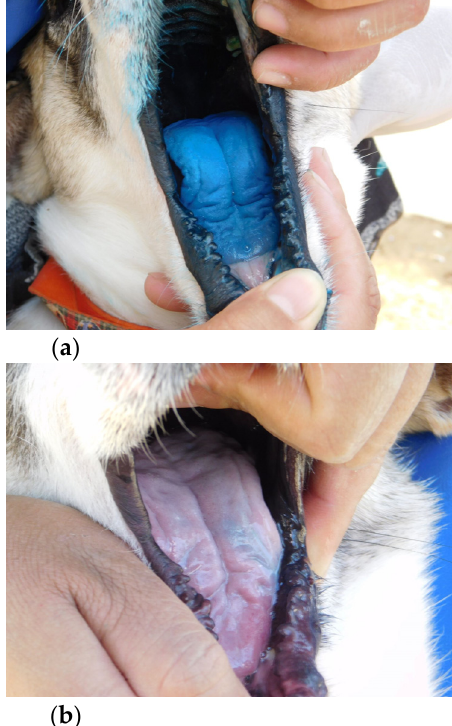
Figure 4. ( a ) Dog with intensive staining of the tongue (score III), indicating the release of a large volume of liquid dye in the oral cavity, compared to ( b ) another dog that showed hardly any staining (score II), indicating that only limited amounts of sachet contents were released in the oral cavity.